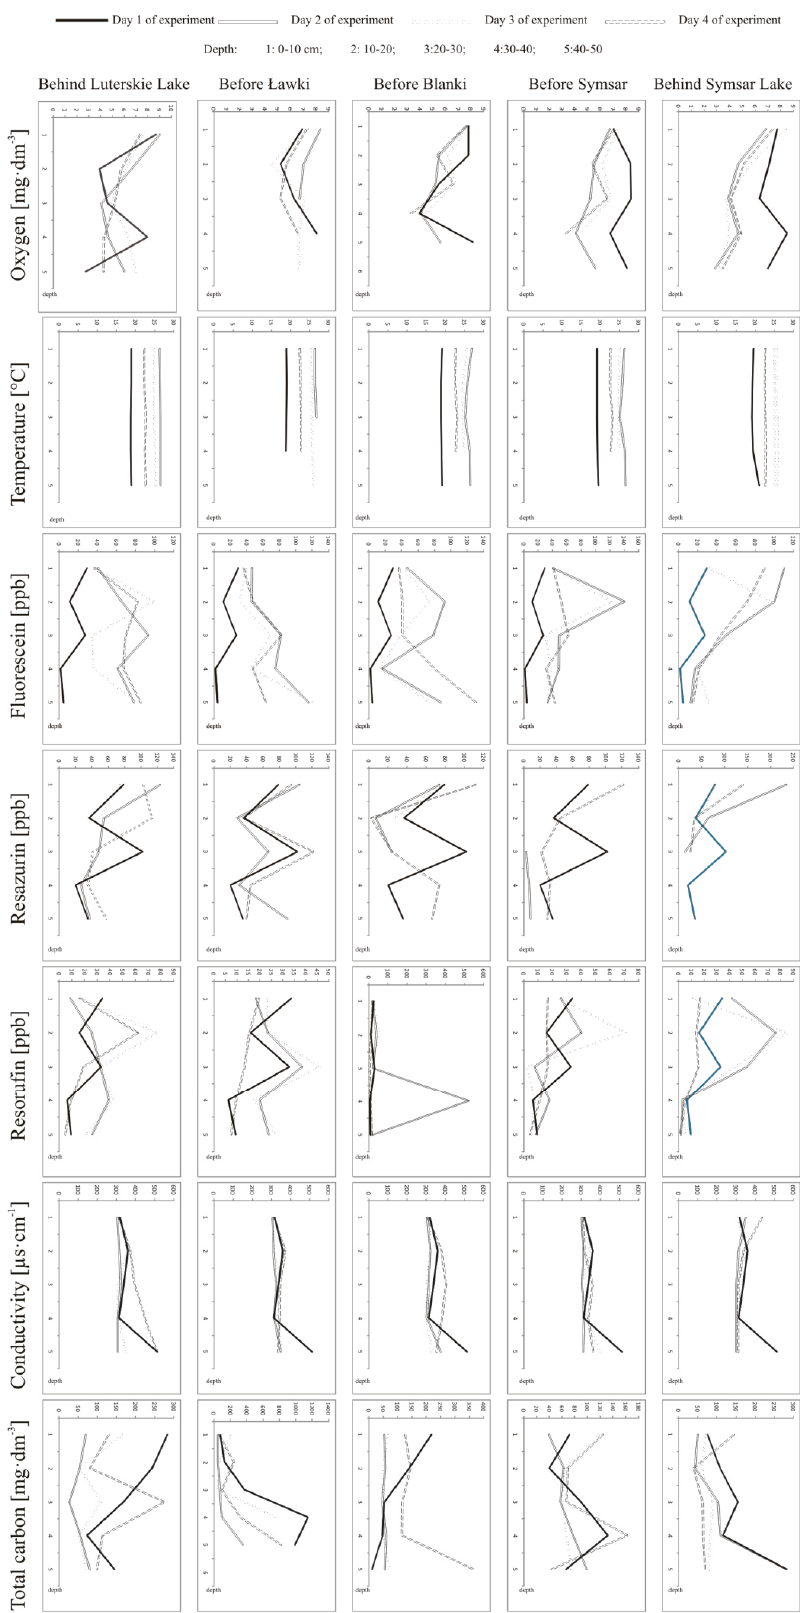
Figure 4. Distribution values of individual indicators of interstitial water of sediments collected at individual locations of the river–lake system in relation to the bottom sediment deposition depth and day of the